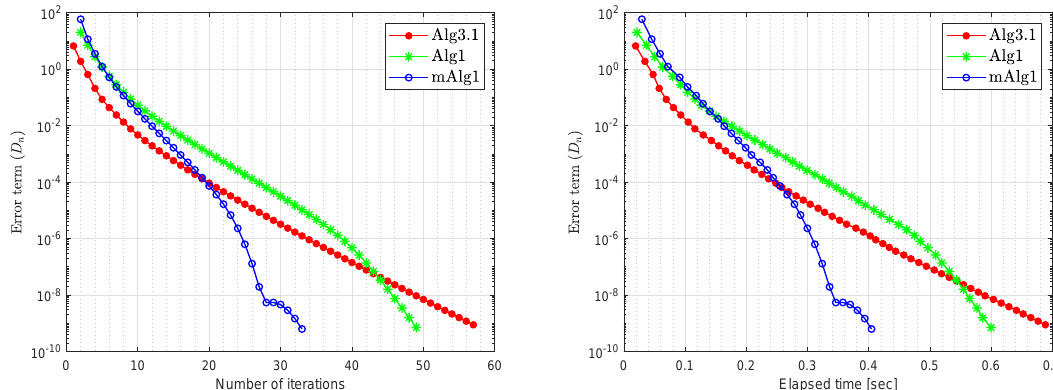
Figure 6. Example 1: Algorithm 1 (mAlg1) numerical comparison with Algorithm 3.1 (Alg3.1) in [39] and Algorithm 1 (Alg1) in [38] while m =